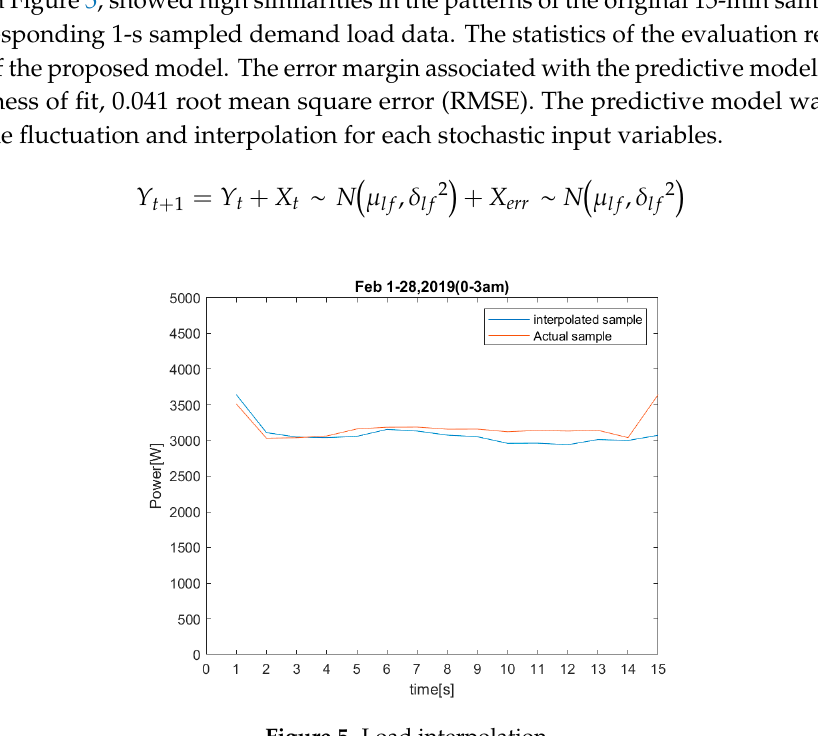
Figure 4. Load fluctuation distribution.